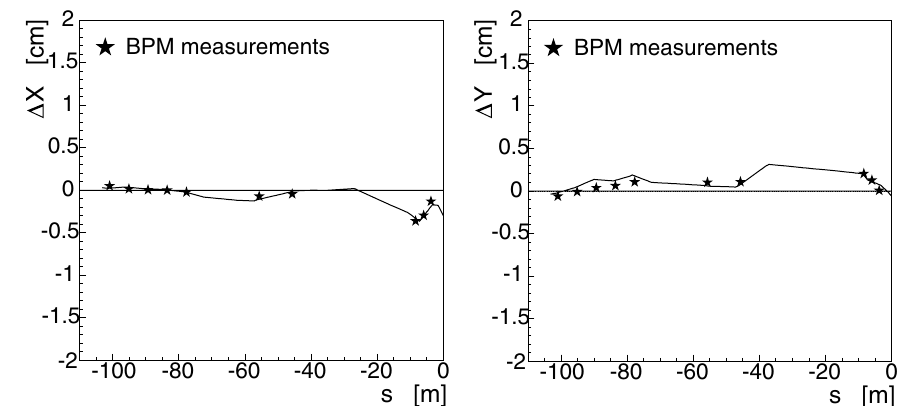
FIG. 1. Example of the orbit-fitting results for KEKB HER around the IP ( s (cid:1) (cid:19) X (cid:1) (cid:19) Y (cid:1) 0 ) without any correction. The left (right) figure shows the horizontal (vertical) fitted orbit together with the BPM measurements. The s axis is taken to be along the orbit. The horizontal line with (cid:19) X (cid:1) (cid:19) Y (cid:1) 0 corresponds to the design orbit. The HER beam flows from the left to the right. (cid:1) 10 : 5 and (cid:1) 2 (cid:1) 40 : 3 =N =N (cid:1) 2 df (cid:3) X (cid:4) df (cid:3) Y (cid:4) X Y (cid:1) 10 : 5 and (cid:1) 2 (cid:1) 40 : 3 for a conserva- (cid:1) 2 =N =N df (cid:3) X (cid:4) df (cid:3) Y (cid:4) X Y